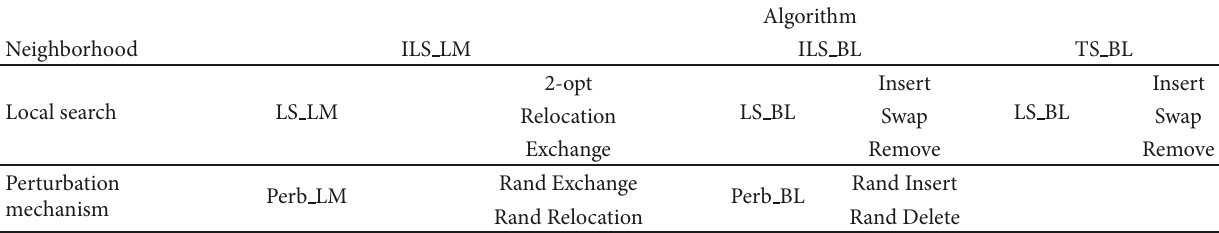
Algorithm 2: ILS for lower-level model. Table 4: Local search and perturbation